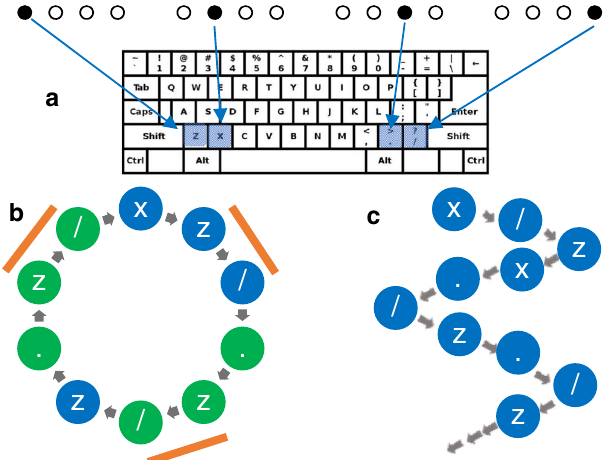
Fig. 1 SRTT. Participants indicated target locations corresponding to four keys ( a ). For example, when the target appeared in the left most location, participants responded by pressing the “ z ” key. Pattern blocks ( b ) consisted of 10-target repeating (5×) sequences, containing three fi rst-order structures (orange bar) and two second-order structures (green circles). Random blocks ( c ) consisted of 50 non-repeating